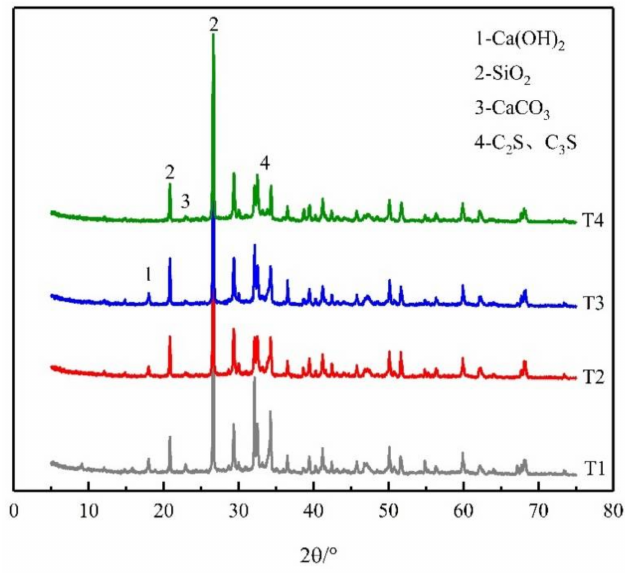
Figure 8. XRD characteristic peaks of UHPC repair materials at different temperatures.